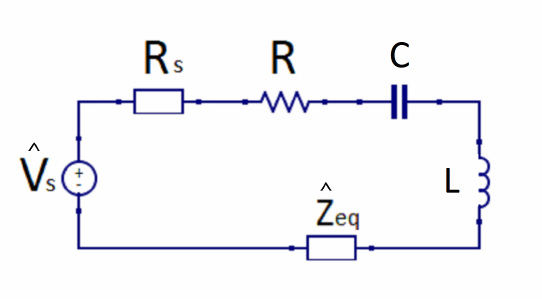
Figure 4. Equivalent circuit of the WPT in terms of an equivalent impedance ˆ Z